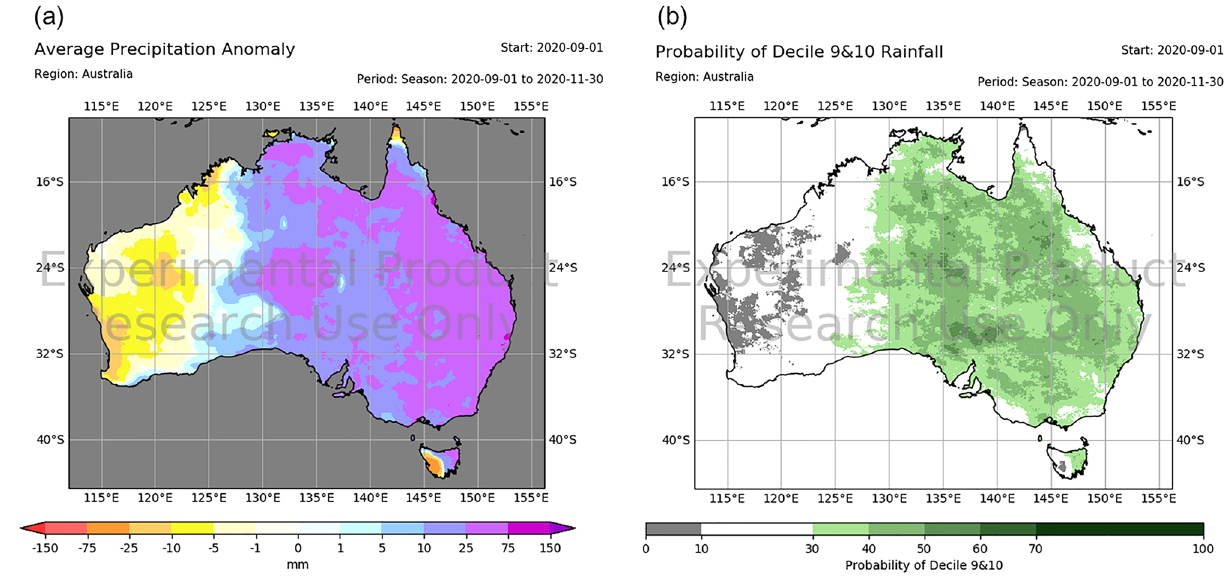
Figure 5. ACCESS-S1 99-member forecasts for spring rainfall, initialised on 1 September 2020. ( a ) Rainfall anomaly and ( b ) probability of Decile 9 and 10 (i.e., top 20% category). Maps were generated with Python version 3.6.1 (https:// www. python. org/).